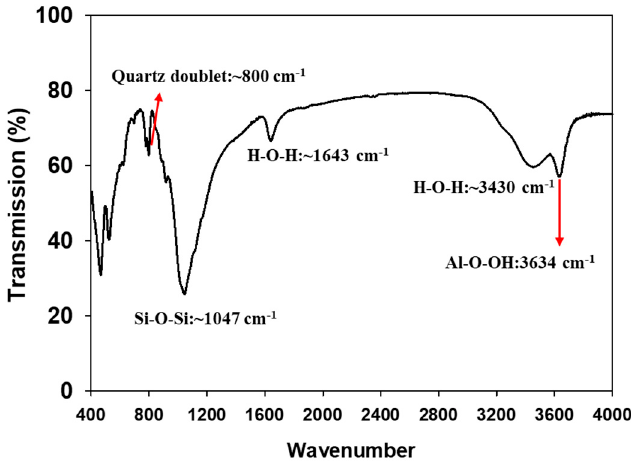
Figure 2. FTIR spectrum of MX-80 bentonite.